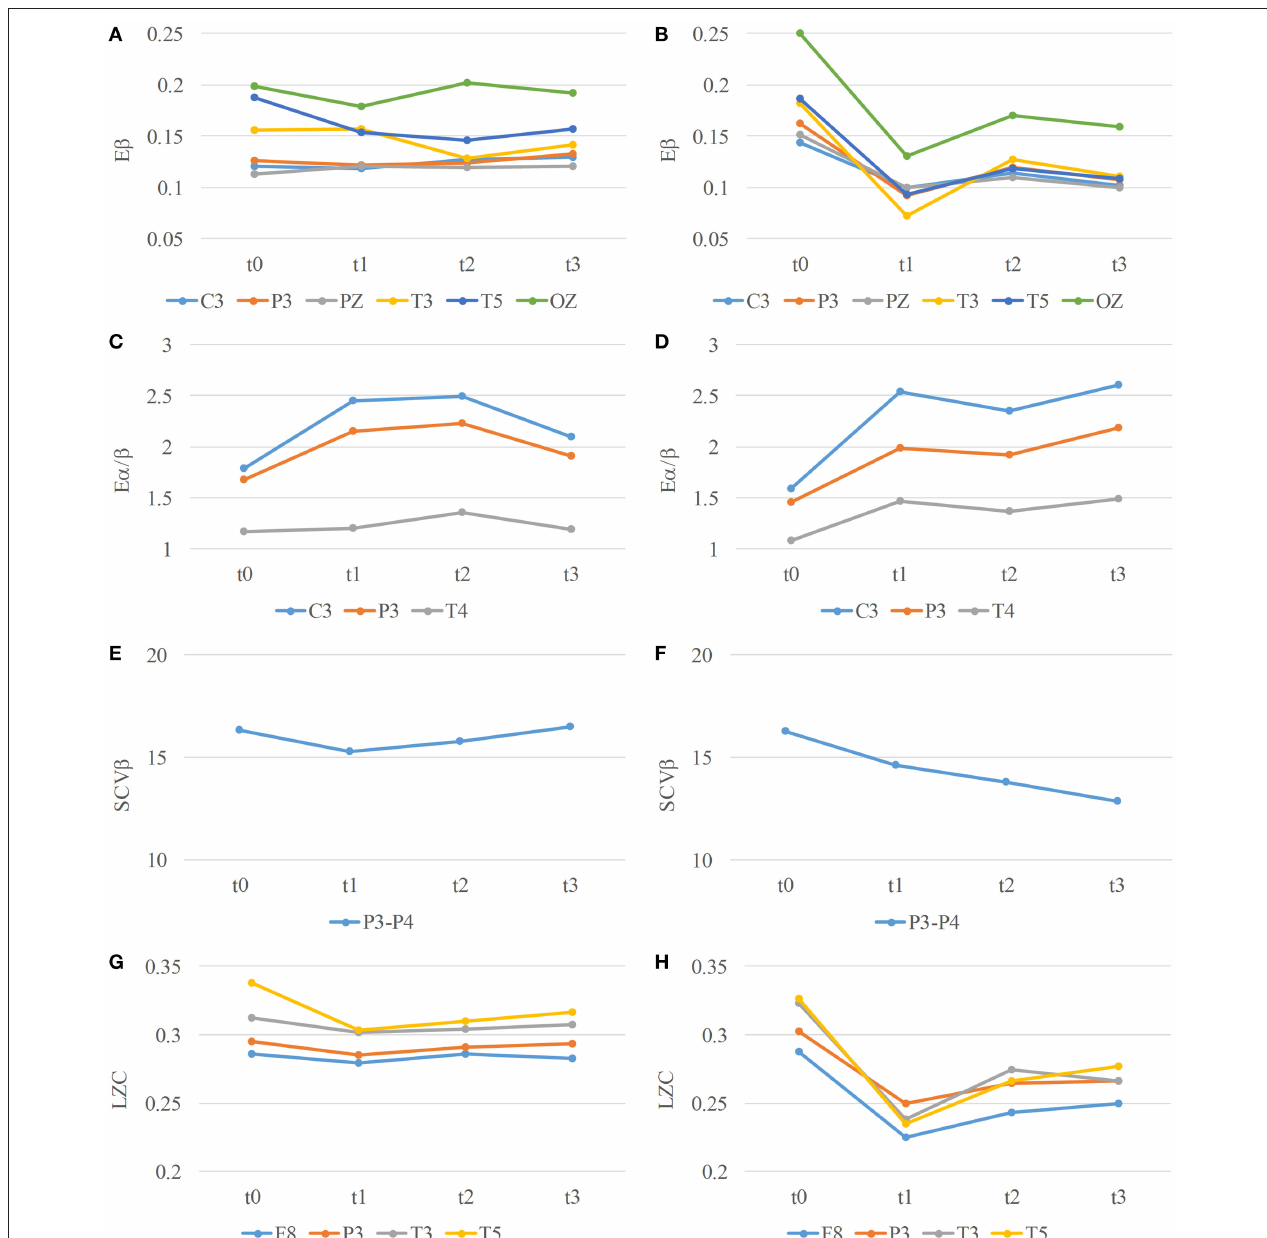
FIGURE 8 | E β (A,B) , E α/β (C,D) , SCV β (E,F), and LZC (G,H) in channels with significance over time for mental (A , C , E,G) and physical mental (B , D , F,H)